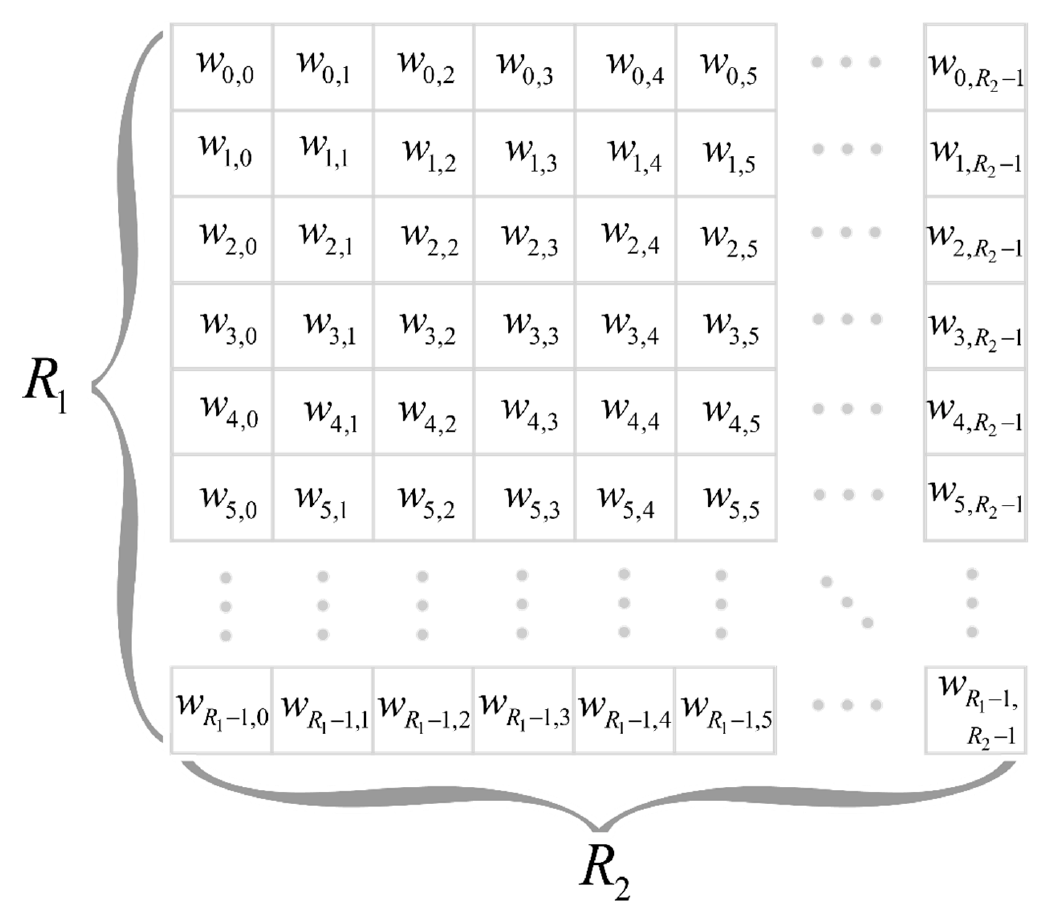
Figure 6. A set of GPU work items.